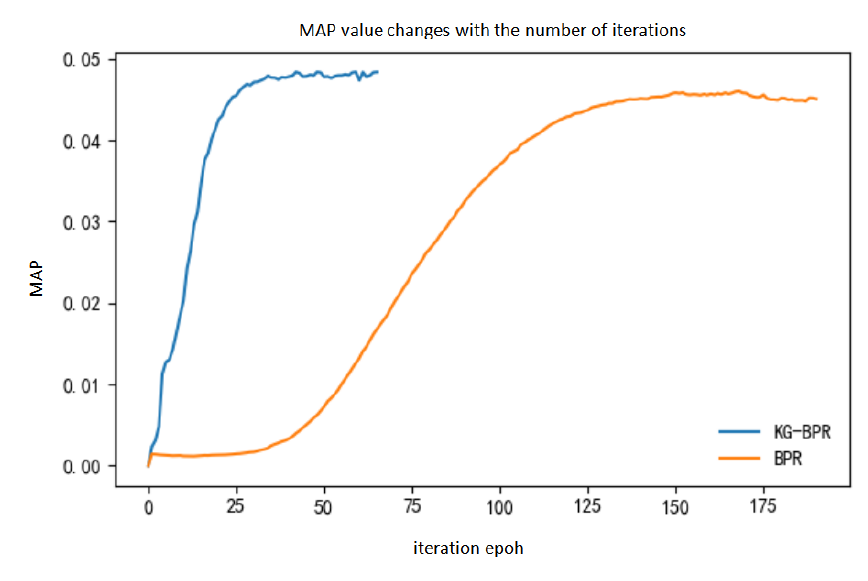
Figure 15. Effect diagram of MAP value changing with iteration